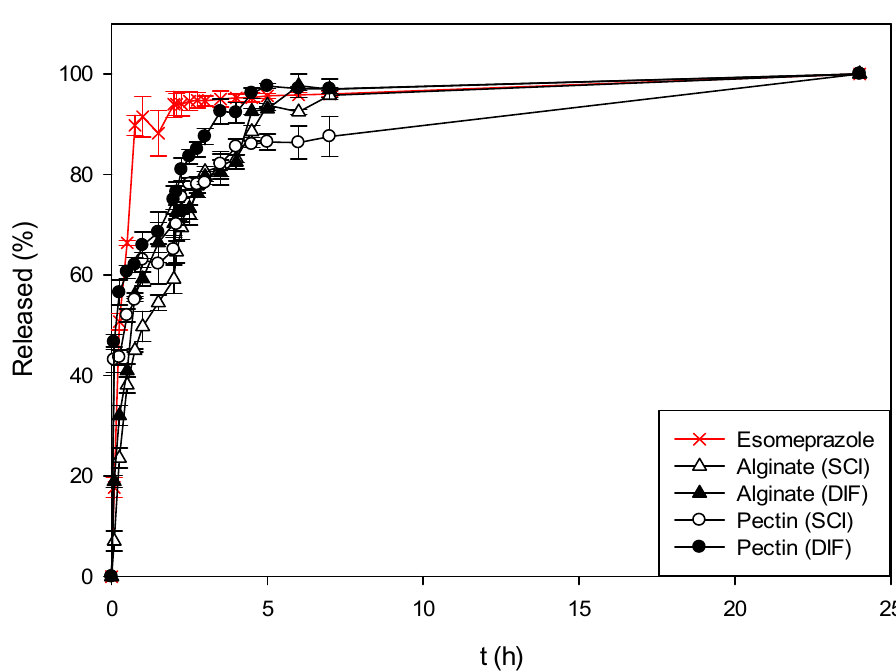
Figure 6. Dissolution profiles of pure esomeprazole and esomeprazole impregnated into neat alginate and pectin aerogels using both impregnation techniques.